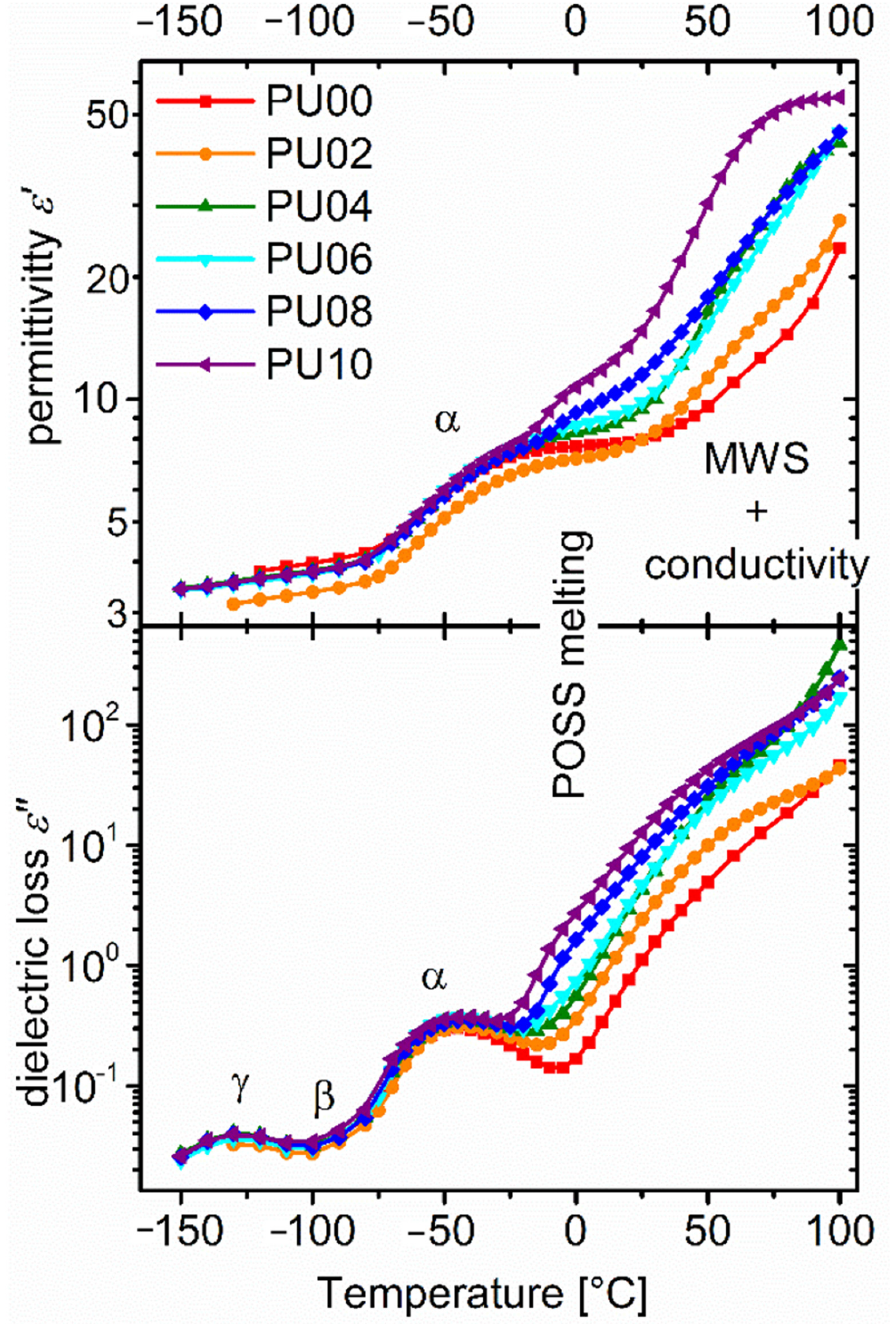
Figure 9. Isochronal plots of the dielectric function for the matrix and the blends, at a frequency of 10 Hz. The observed processes are annotated.